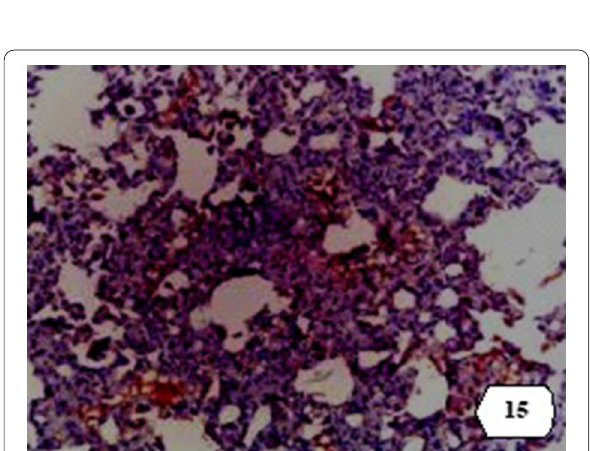
Fig. 15 Lung tissue image of Ch-NPs moderate positive COX-2 immunoreactivity (